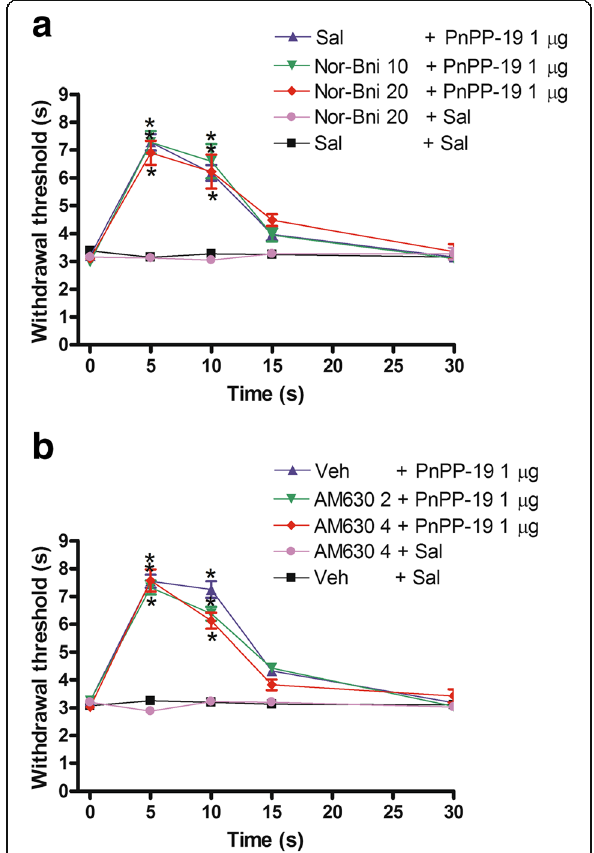
Fig. 3 Intracerebroventricular administration of a nor-binaltorphimine or b AM630 on the central antinociception produced by PnPP-19. Nor-binaltorphimine (Nor-Bni; 10 and 20 μ g) or AM630 (2 and 4 μ g) was administered 1 min prior to PnPP-19 (1 μ g) injection. These antagonists did not significantly modify the nociceptive threshold in the control group. Each line represents the mean ± SEM for four mice per group. *Significant difference compared to Sal + Sal or Veh + Sal injected groups (ANOVA + Bonferroni ’ s test). Sal: saline (0.5% of Evans Blue); Veh: vehicle (20% DMSO in saline 0.5% of Evans Blue)